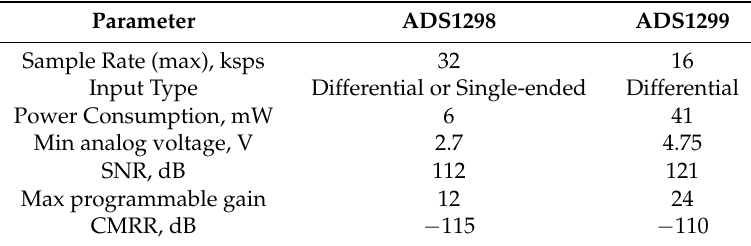
Table 2. Main differences of ADS1298/9 devices.